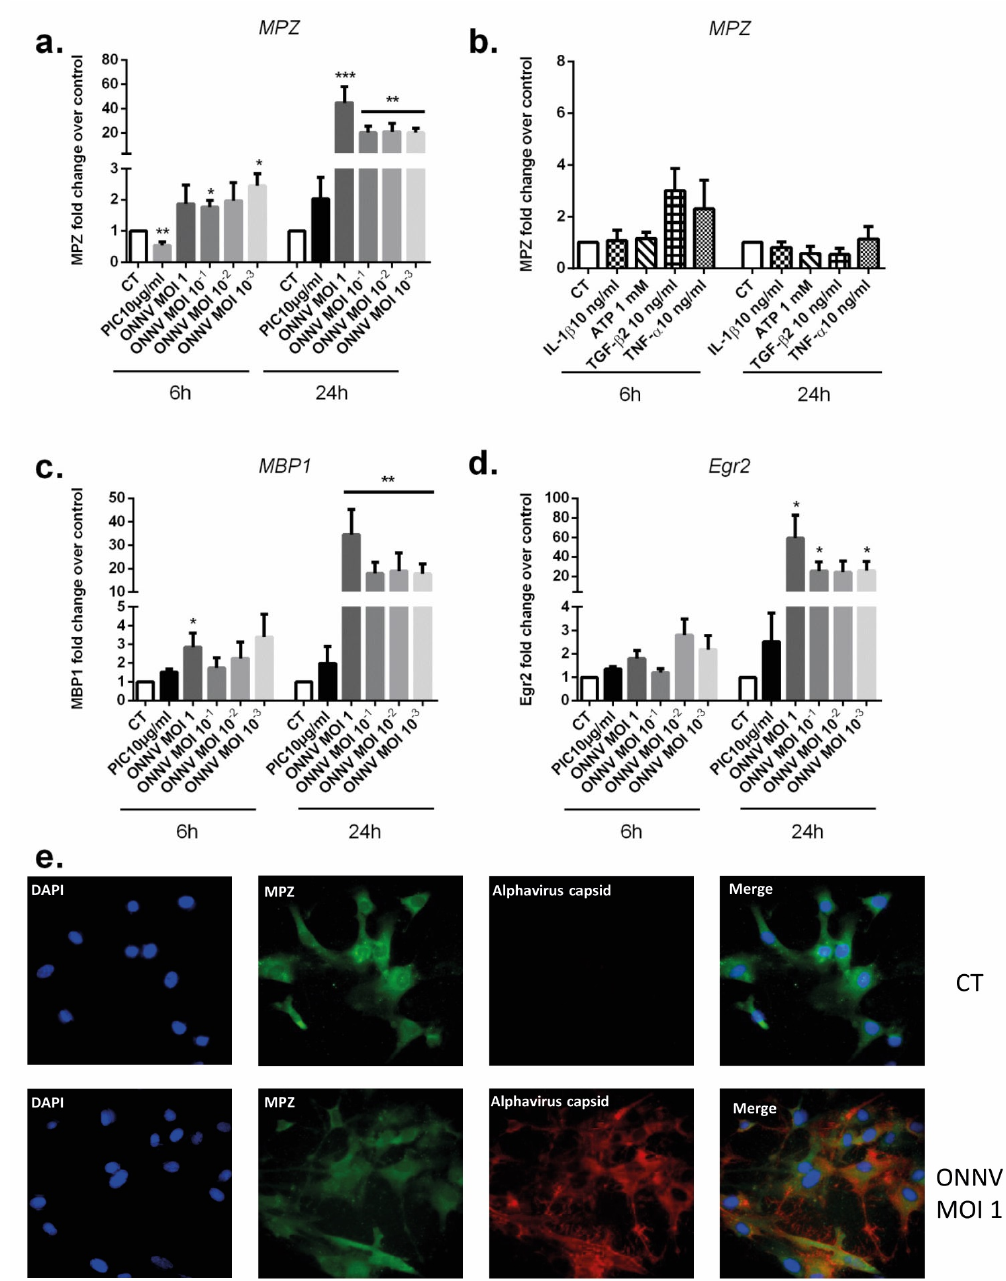
Figure 9. SC upregulated the expression of myelin-related genes in response to ONNV infection. ( a ) MPZ mRNA levels were assessed by qRT-PCR in SC infected by ONNV (MOI 10 − 3 to 1) or exposed to PIC 10 µ g/mL, ( b ) IL-1 β 10 ng/mL, TNF- α 10 ng/mL, TGF- β 2 10 ng/mL, and ATP 1 mM. ( c ) MBP1 and ( d ) Erg2 gene expression were quantified by qRT-PCR in SC infected by ONNV or stimulated by PIC 10 µ g/mL for 6 h and 24 h. All experiments were done in quadruplicates. Results are expressed as mean ± SEM and presented as a normalized fold increase vs. control. * p -values ≤ 0.05, ** p -values ≤ 0.01, and *** p -values ≤ 0.001 represent significant differences from controls by one-way ANOVA followed by the Bonferroni’s test analysis. ( e ) SC were cultured on coverslips, incubated with ONNV (MOI 1) for 24 h, or mock infected (CT) and analyzed by fluorescence microscopy. Immunostaining was performed using rabbit anti-CHIKV capsid and Alexa Fluor 594 (red)-conjugated donkey anti-rabbit or mouse anti-MPZ and Alexa Fluor 488 (green)- conjugated donkey anti-mouse. Nuclei were counterstained with DAPI